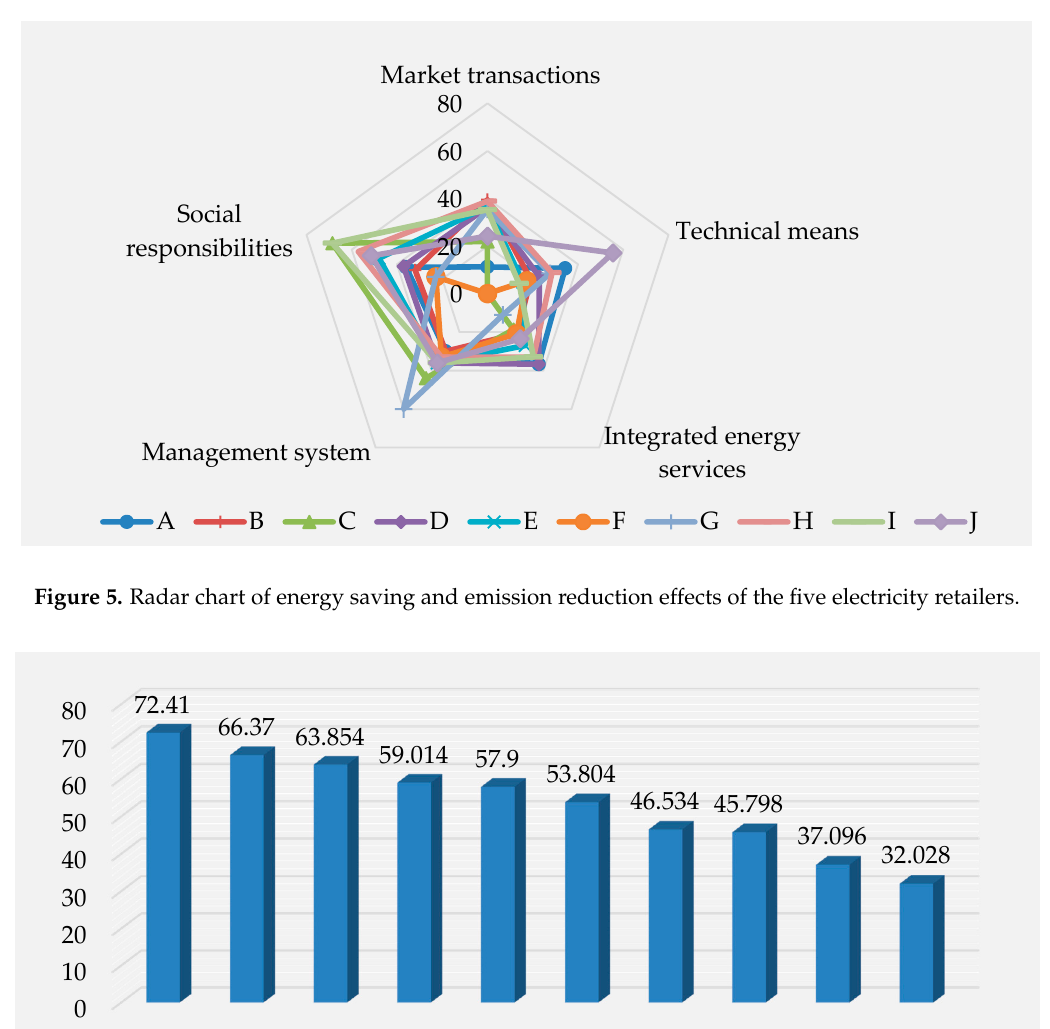
Table 10. Two-level fuzzy comprehensive evaluation results.